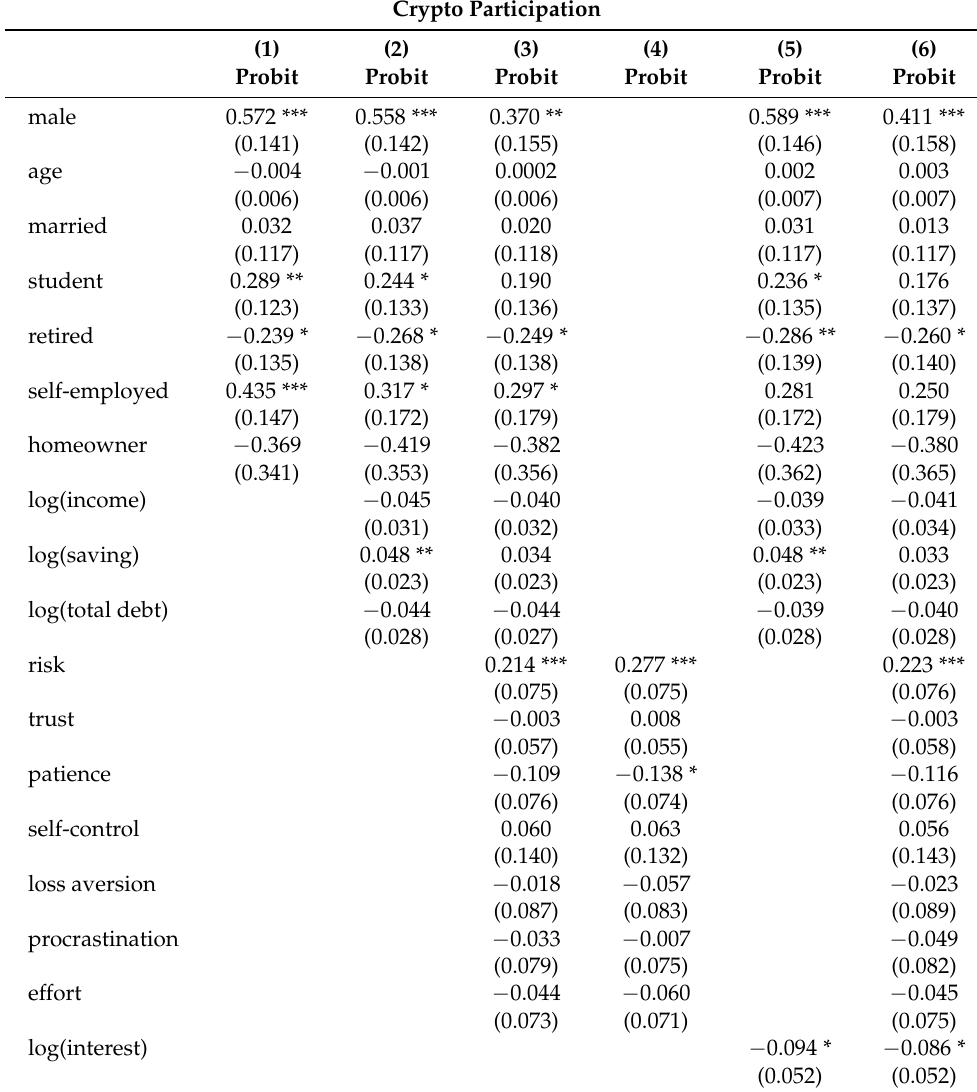
Table 5. Probit regression of crypto participation. Source: Own